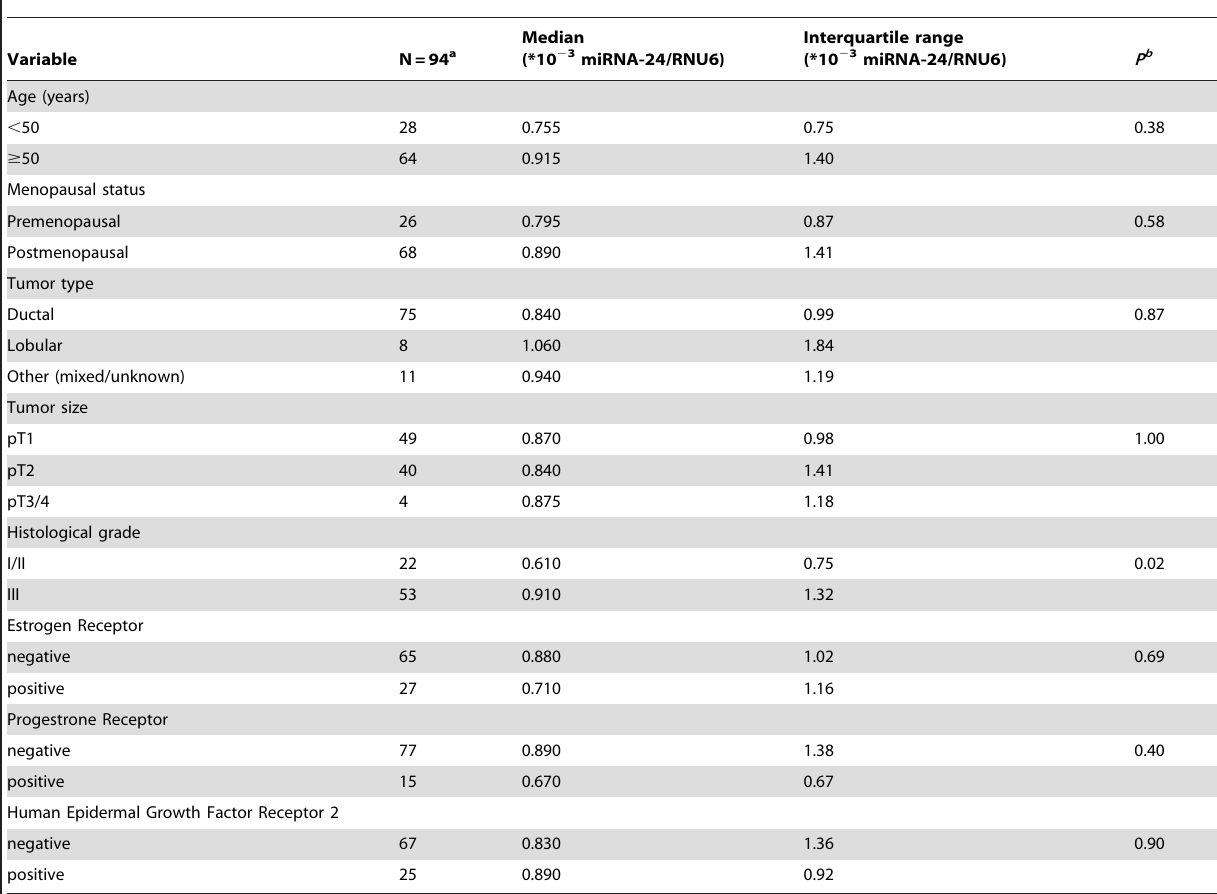
Table 3. Associations of miRNA-24 expression levels with clinicopathological